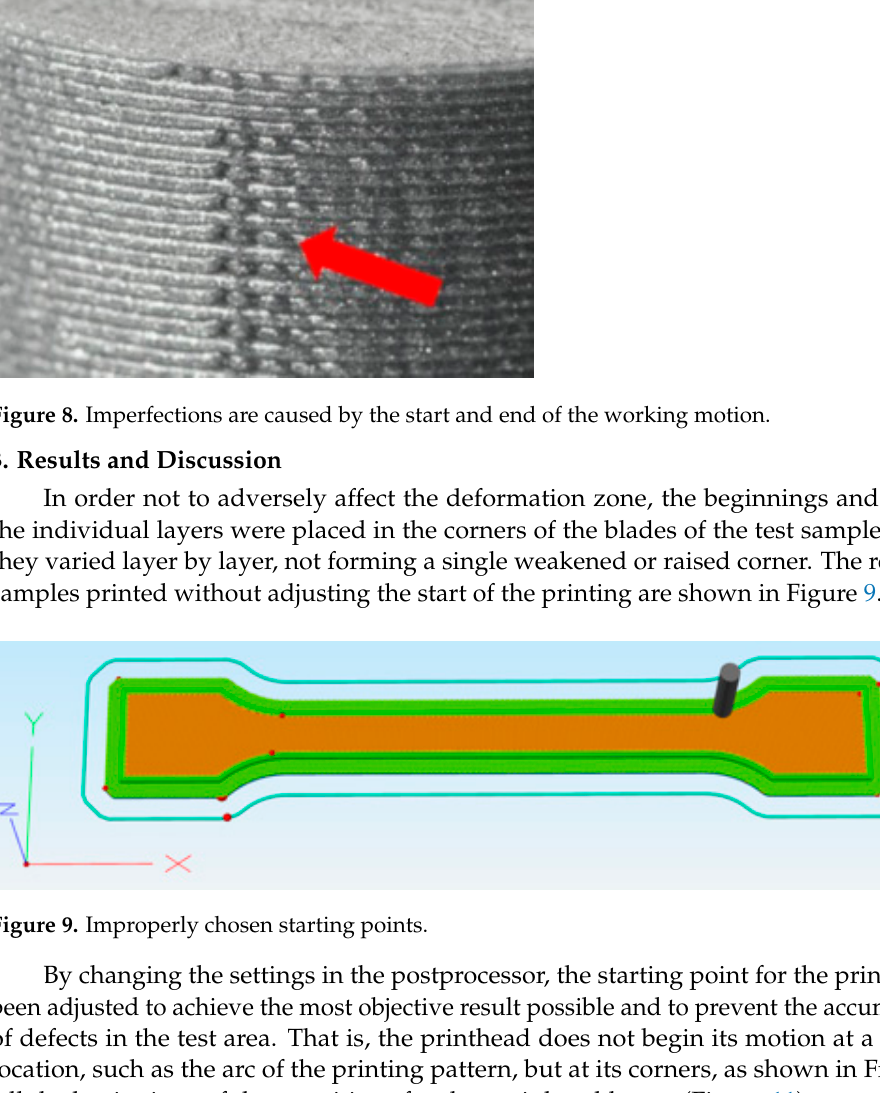
Figure 11. Beginnings of working motion outside the monitored zone. As mentioned at the beginning of the paper, the starting sample for comparison and evaluation of the measurement results is a sample of pure PLA, free from dyes and addi- tives. Other studied materials are composites composed of PLA plastic with different per- centages of admixtures. To determine the effect of the orientation of the infill in the sample to be torn, when applying the FDM technology, a series of samples is created from mate- rials gradually containing an admixture of dust particles of copper, steel, and iron. For the given models, 10 samples of pure PLA material have been made for all five orientations. Composite samples were produced only in the 0° orientation. The result of the measurements is a document with individual values obtained in course of the measurement. The measurement is repeated for each test sample and finally evaluated using tables and graphs. The measured and calculated values obtained in the